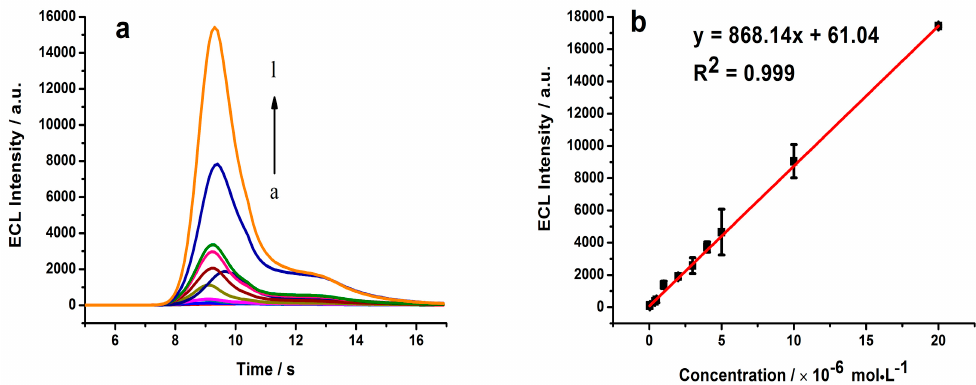
Figure 6. ECL responses of the 3D-CNFs/GCE in a 0.1-M borate buffer solution ( a ) for different concentrations of difenidol hydrochloride ranging from 3 × 10 − 8 to 2 × 10 − 5 mol · L − 1 ; ( b ) calibration curves of the ECL responses for different difenidol hydrochloride concentrations. Error bar: standard deviation for n = 3. Table 2. Comparison of di ff erent methods used for the detection of difenidol hydrochloride.